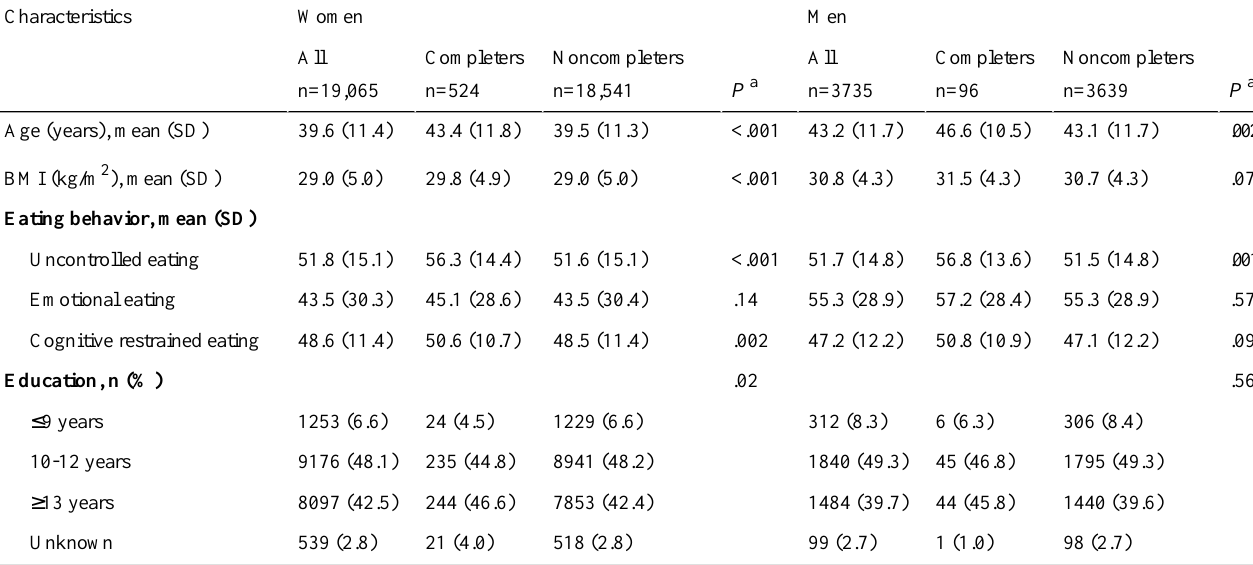
Table 1. Baseline characteristics of the study participants (N=22,800). MenWomenCharacteristics